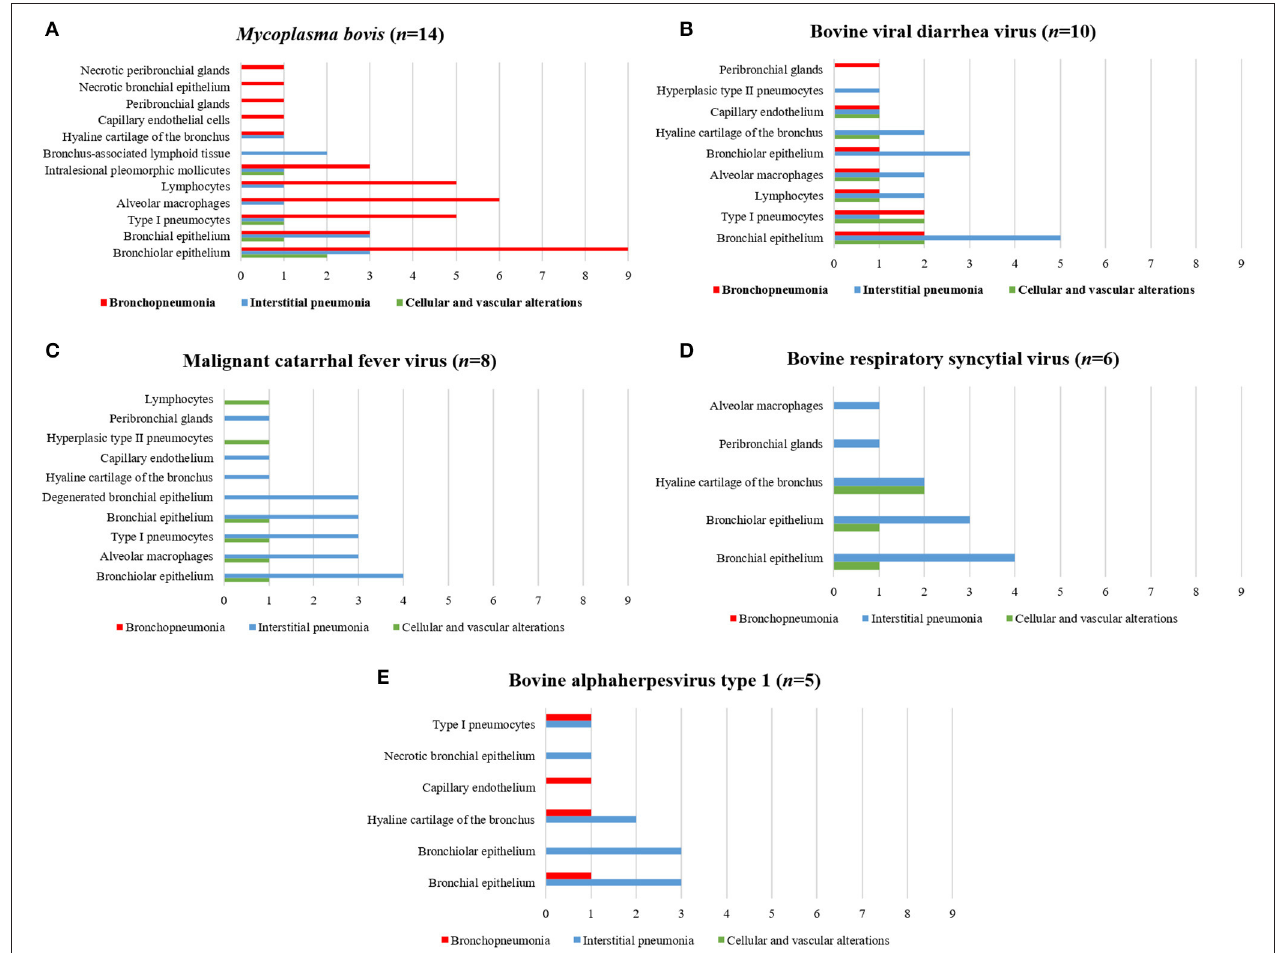
FIGURE 2 | Comparative distribution of the IHC identification of antigens of single infectious disease pathogens within the lungs of cattle with BRD due to (A) M. bovis , (B) BVDV, (C) MCFV, (D) BRSV, and (E) BoHV-1. Bar: green, cellular and vascular alterations; blue, interstitial pneumonia; and red,